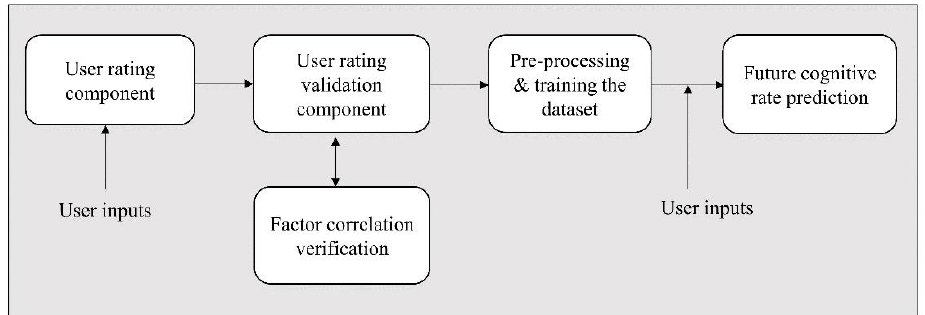
Fig. 1. Proposed system